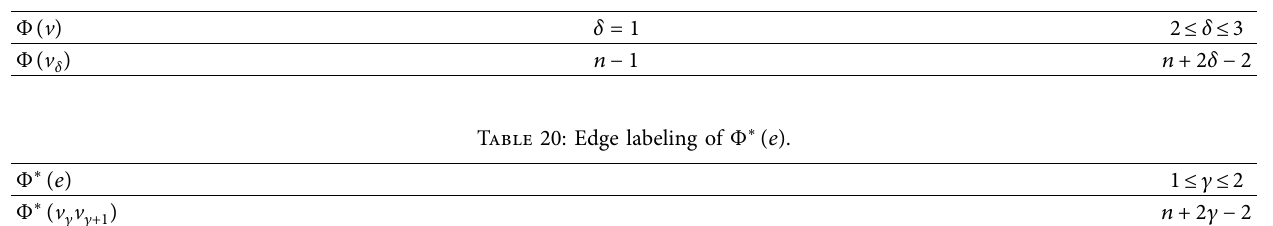
Table 19: Vertex labeling of Φ ( v ).